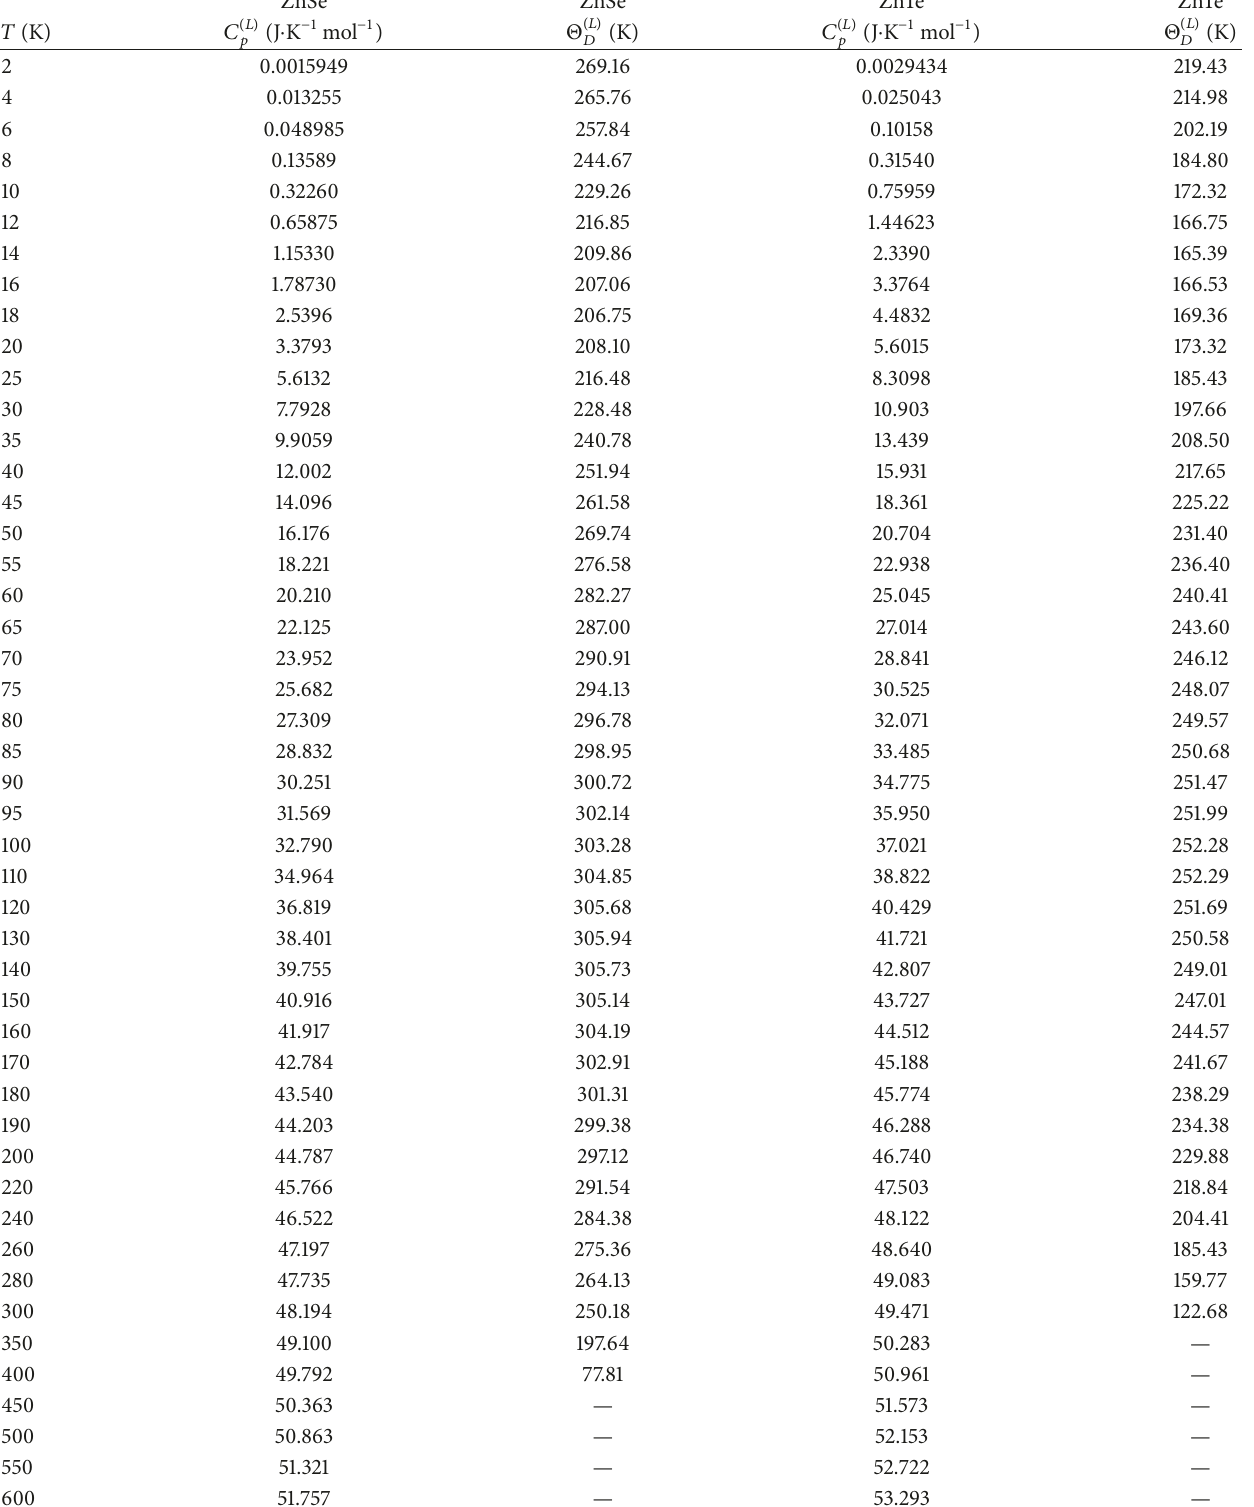
Table 2: Smoothed values of the isobaric lattice heat capacities, 𝐶 (𝐿) 𝑝 (𝑇) = 𝐶 𝑝 (𝑇) − 𝑐 1 𝑇 , and of the corresponding (effective) Debye temperatures, Θ (𝐿) 𝐷 (𝑇) (due to (27) and